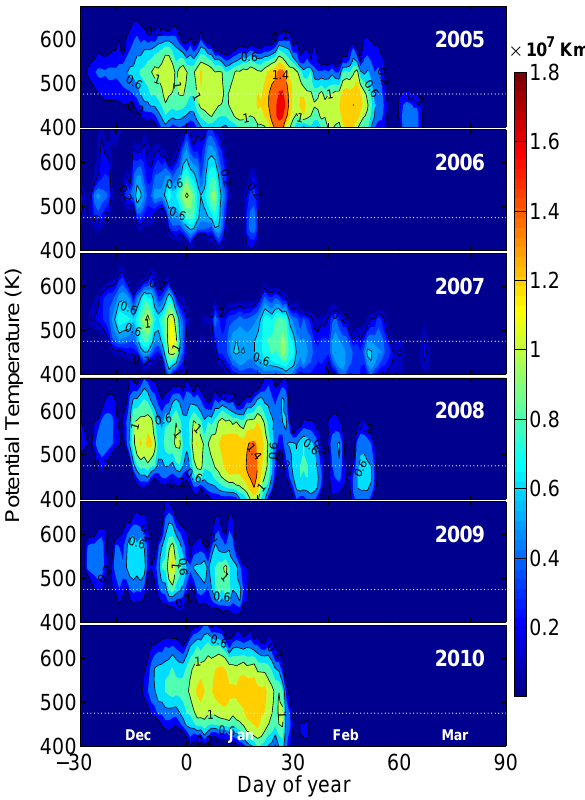
Fig. 1. The area (km 2 ) covered by PSCs (between 400 and 675K) inferred from the ECMWF temperature data for the Arctic winters 2005–2010. PSCs are assumed to form at the NAT frost point. The dotted line represents the 475K and the topmost boundary stands for 675K potential temperature